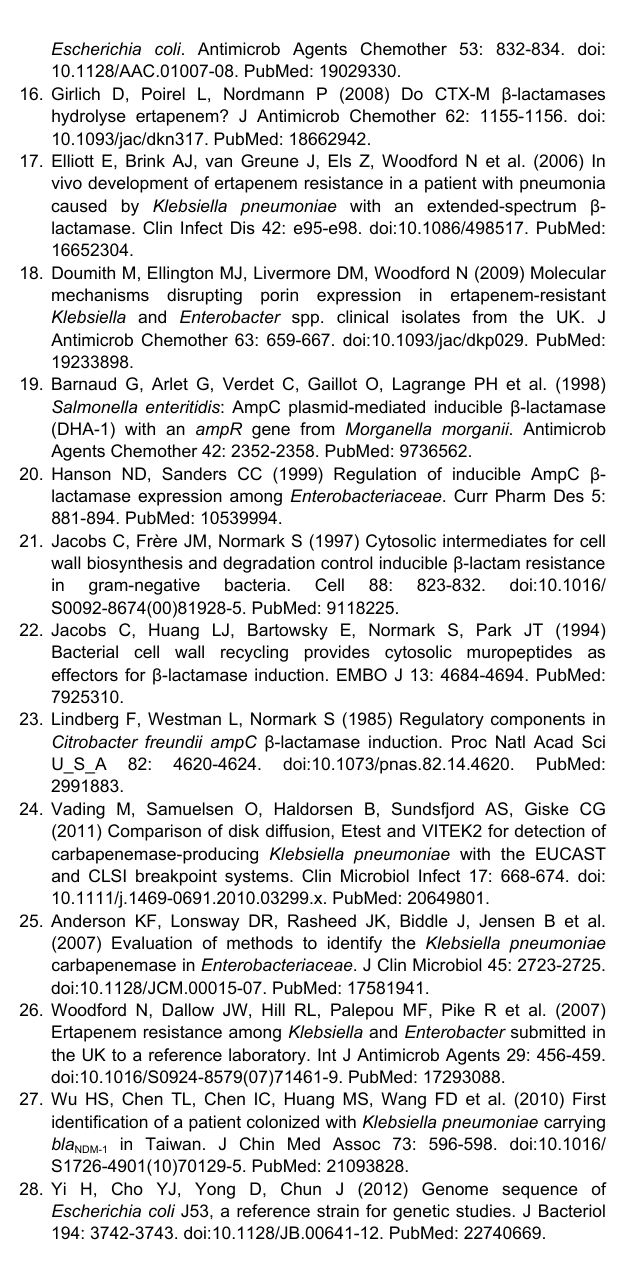
Table S1. Oligonucleotide primers used in this study.